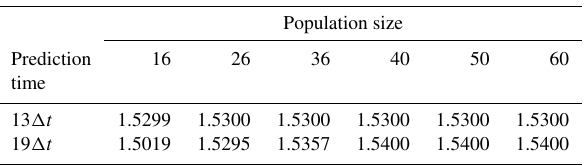
Figure 8. Local distribution of the OFV at the prediction time 22 (cid:49)t nearby the CNOP point.